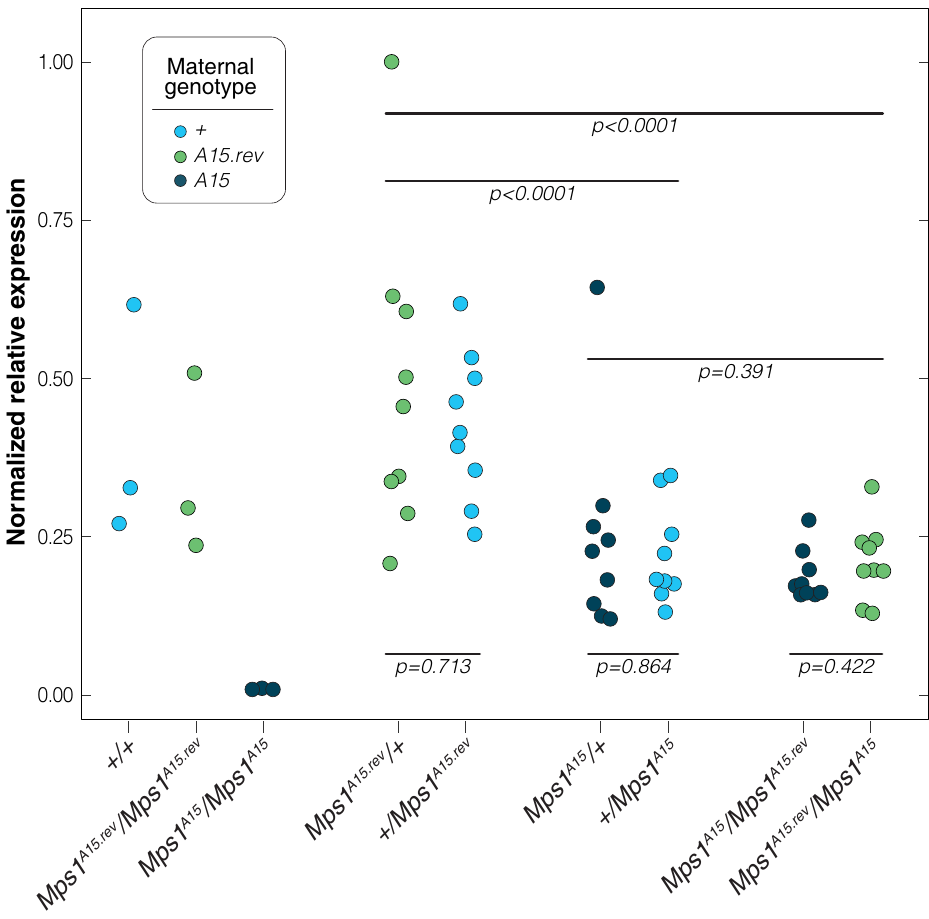
Fig 6. Relative expression (plate normalized) of Mps1 in ovaries is determined strictly by genotype and the dose of A15 alleles, indicating a strict zygotic effect on gene expression. Reciprocal progeny of all three pairwise crosses show similar expression levels, indicating no maternal effect. Expression levels of Mps1 in Mps1 A15 /+ and Mps1 A15 / Mps1 A15 . rev are intermediate between Mps1 A15 / Mps1 A15 homozygotes and +/+ (or Mps1 A15 . rev / Mps1 A15 . rev ) homozygotes, indicating a strict dose effect of Mps1 A15 on Mps1 expression. Relative expression levels are normalized to maximum 1.0.